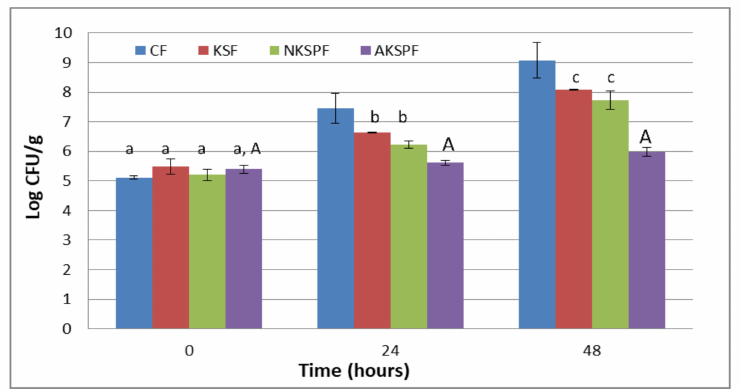
Figure 3. Antimicrobial capacity of films (Barrier test) against Z. bailii : CF (without KS neither particles), KSF (with KS not retained in particles), NKSPF (with KS retained in NKSP particles) and AKSPF (with KS retained in AKSP particles). Same lower-case letters indicate non-significant differences among films at the same time ( p > 0.05). Same capital letters indicate non-significant differences for the same film at different times ( p >